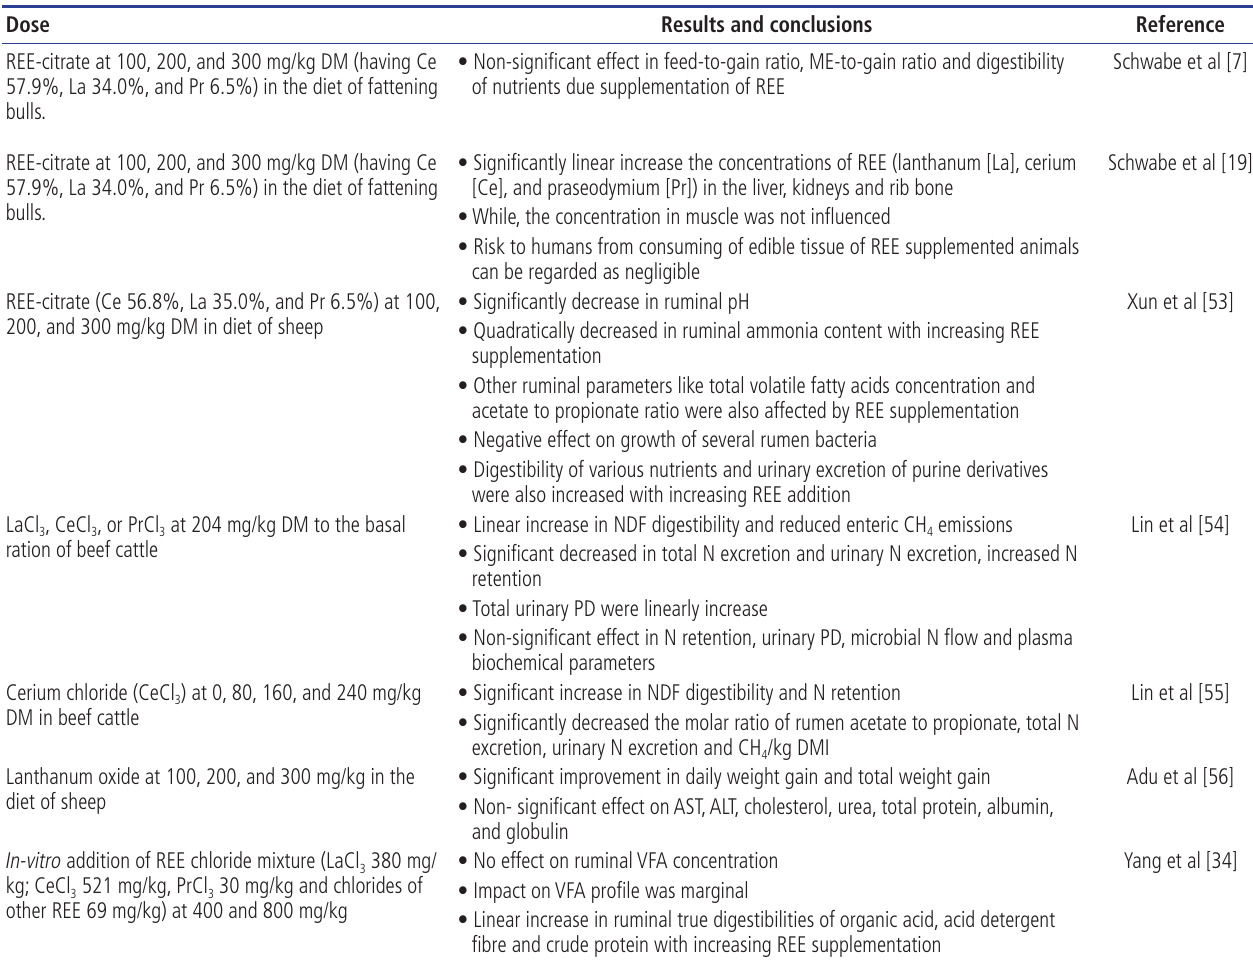
Table 3. Literature summary of effect of REE supplementation in ruminants Dose Results and conclusions